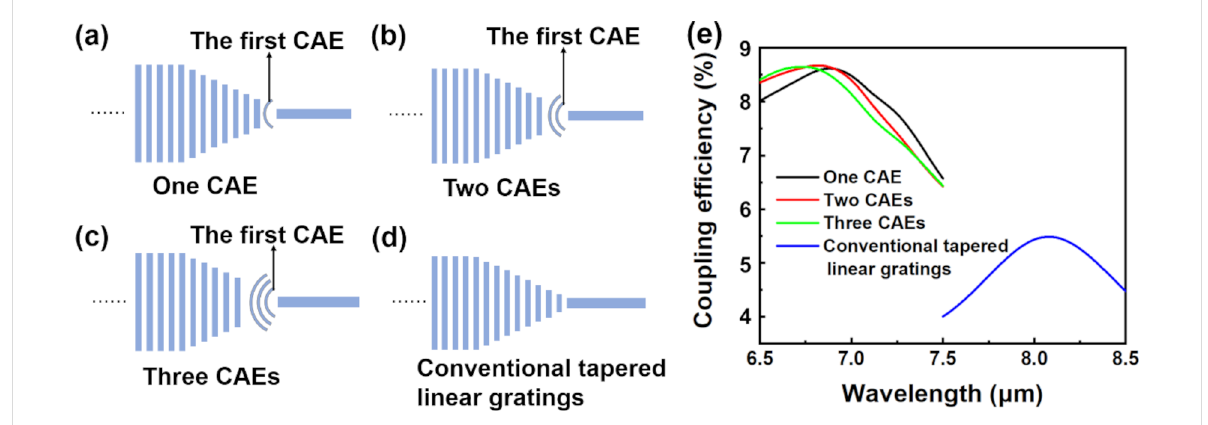
Figure 5: Structures of MIR grating couplers with (a) one single CAE, (b) two CAEs, (c) three CAEs, and (d) conventional tapered linear gratings. (e) Comparison of coupling efficiency of MIR FGCs with different structures.